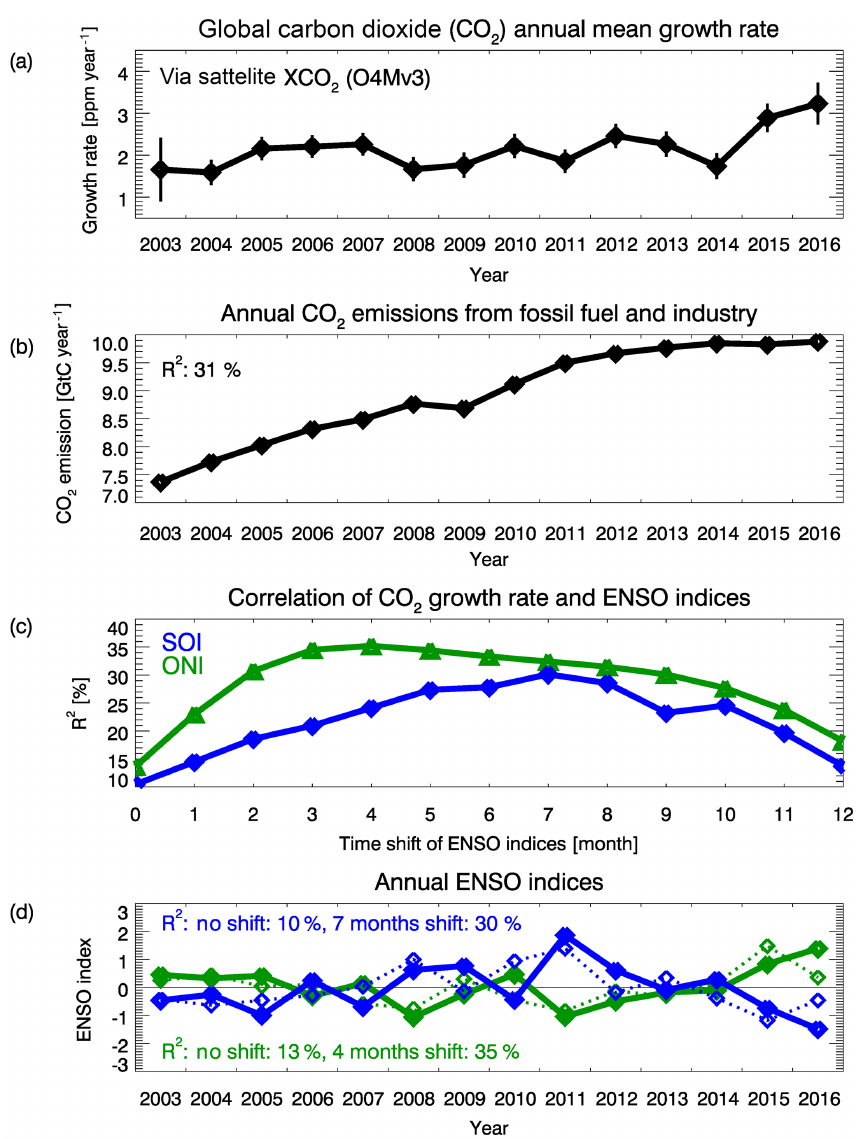
Figure 3. Carbon dioxide global annual mean growth rates compared with human emissions and ENSO indices. (a) Satellite-derived global annual mean growth rates (with 1 σ uncertainty range shown as vertical lines). (b) CO 2 emissions from fossil fuel and industry (the correlation with the growth rate is R 2 = 31%). (c) Correlation in terms of R 2 of growth rate and annual SOI (blue curve) and ONI (green curve) as a function of time shift in months. (d) Annual SOI for no shift (blue dotted line, R 2 = 10%) and for a shift of 7 months (blue solid line, R 2 = 30%) and annual ONI for no shift (green dotted line, R 2 = 13%) and for a shift of 4 months (green solid line, R 2 =